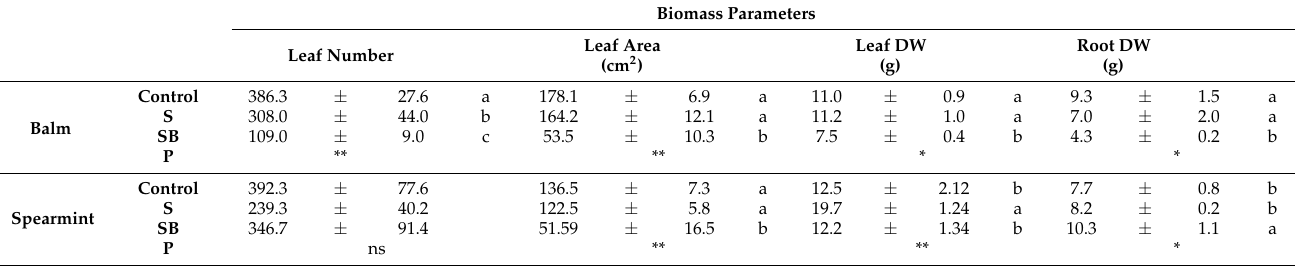
Table 1. Leaf mineral content of balm and spearmint plants at 15th day. Values are mean ± S.E. of six plants.